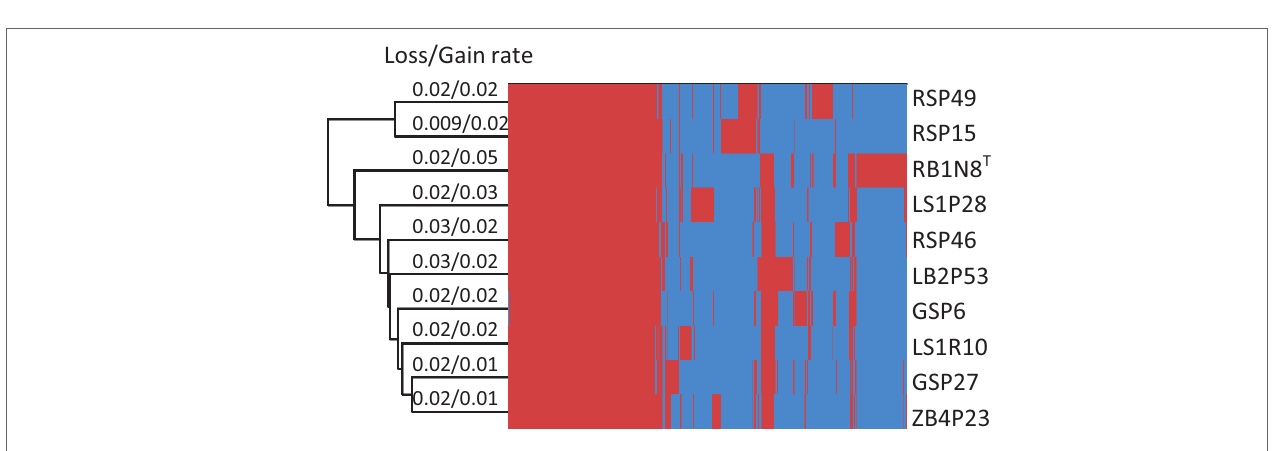
FIGURE 3 | Hierarchical clustering of 10 strains based on the heatmap of the orthologous genes. The presence and absence of the orthologous genes for each strain are indicated in red and blue color, respectively.